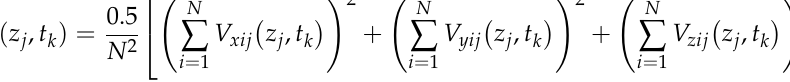
Figure 1. Diurnal hourly dynamics of the wind velocity vector southern—downwards, east—to the right, and western—on the left).